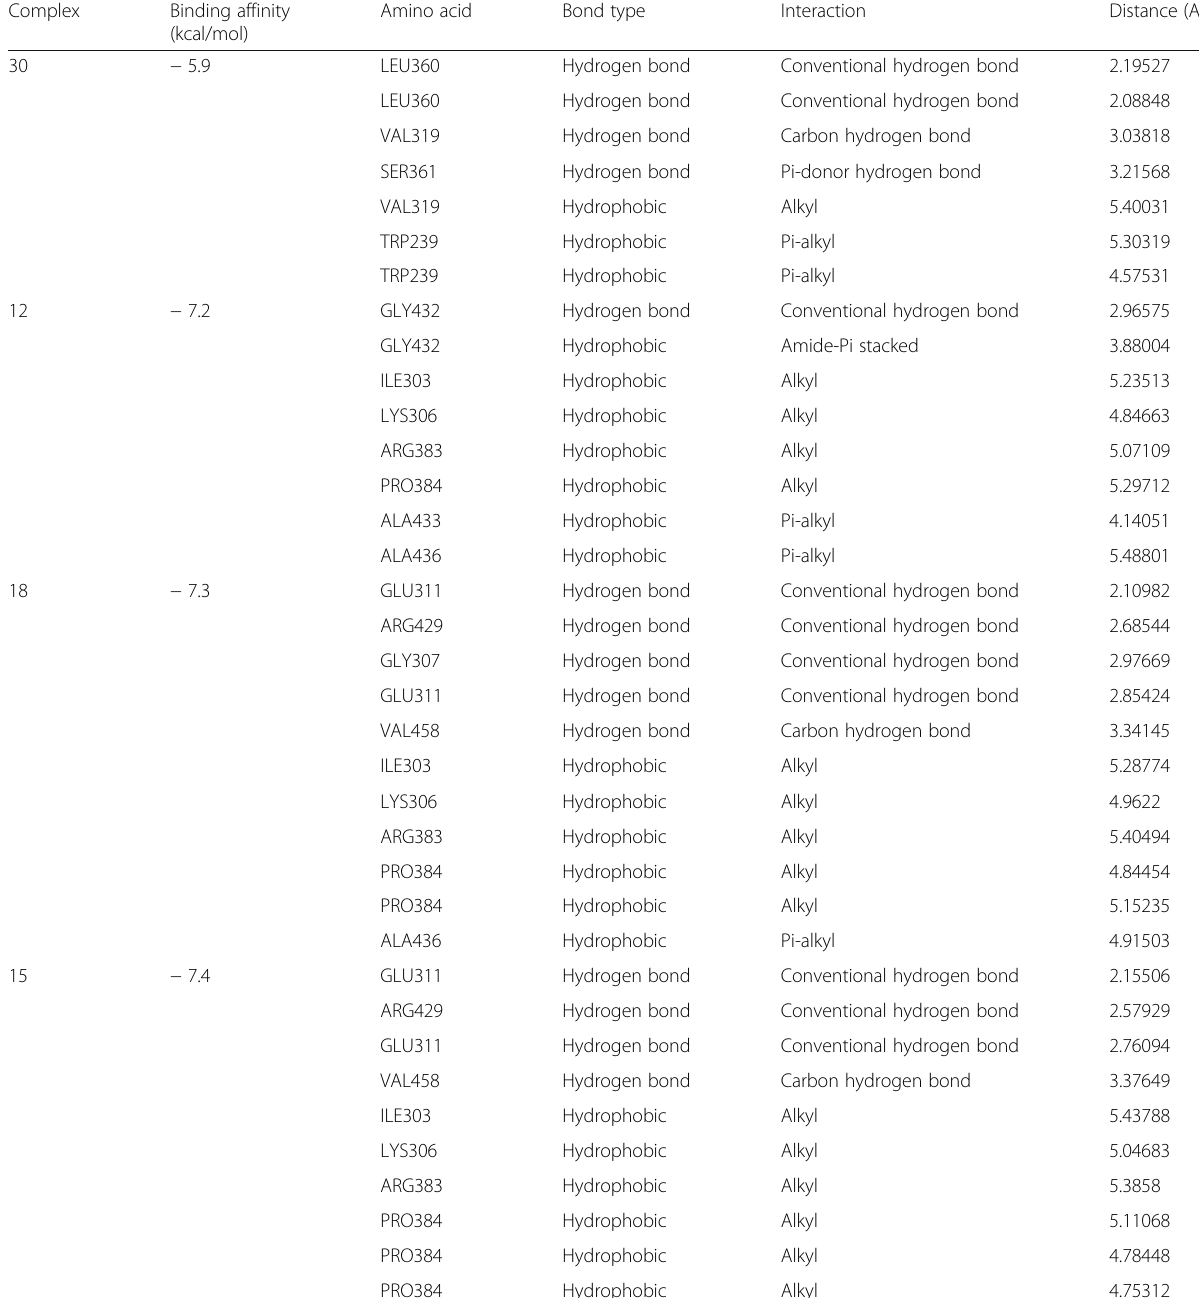
Table 8 Binding affinity, interaction type, bond type, and distances in between some compounds and the receptor